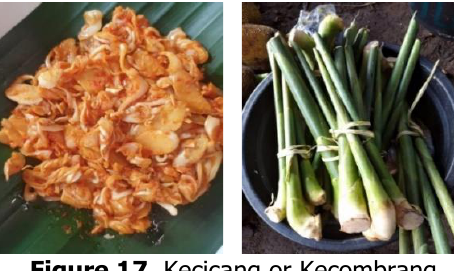
Figure 17. Kecicang or